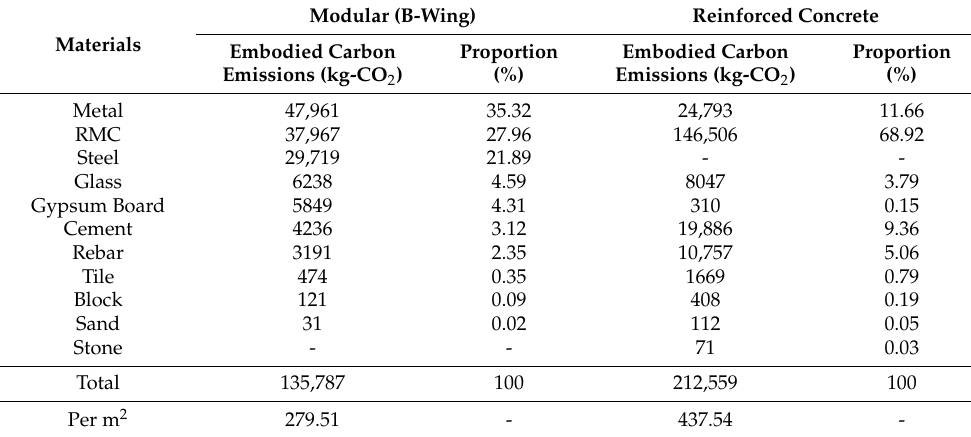
Table 5. Results of the assessment of the embodied carbon emissions.